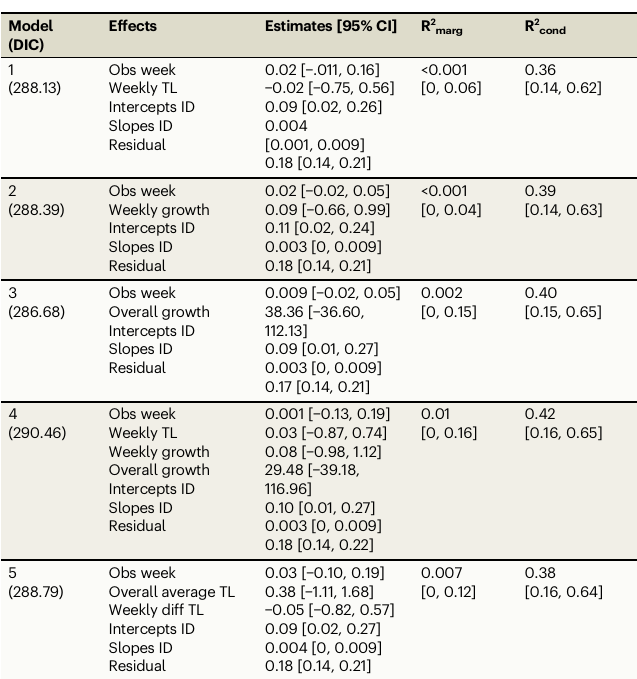
Table 3) and when considering behavior across the entire fi rst week of life combined (R =0.57 [0.41, 0.50], Supplementary 4). As median